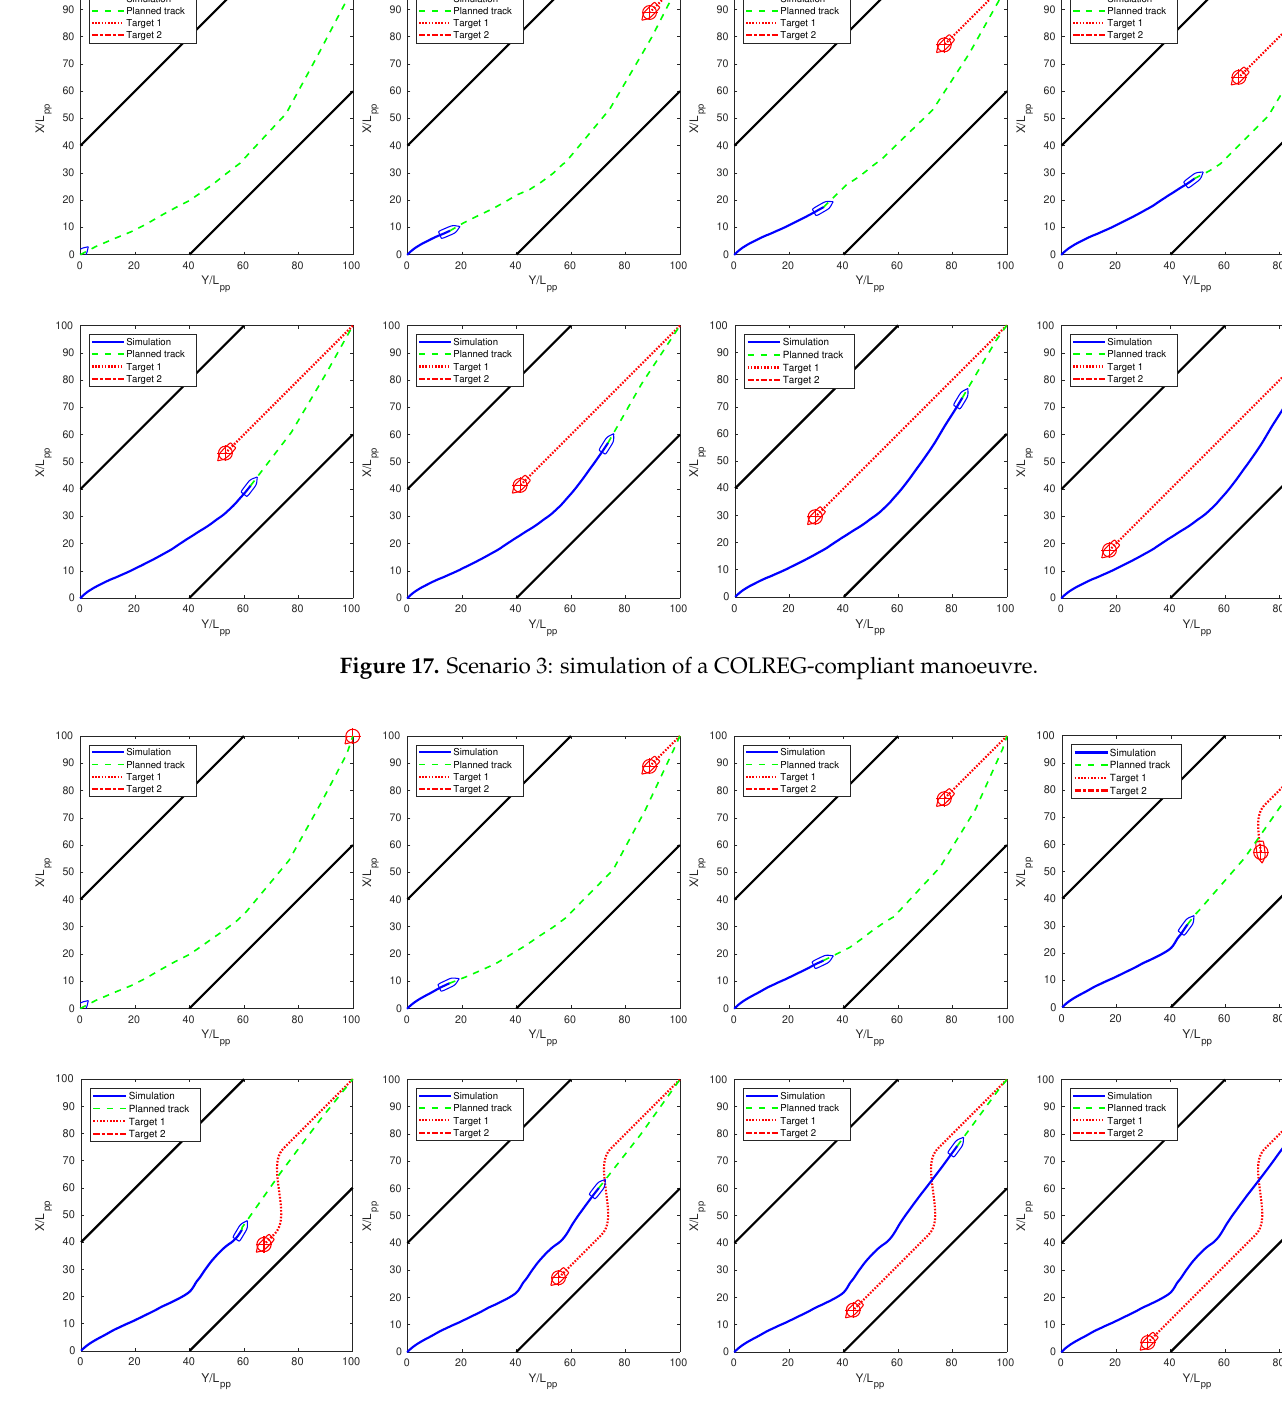
Figure 18. Scenario 3: simulation of a COLREG-compliant manoeuvre with unexpected target